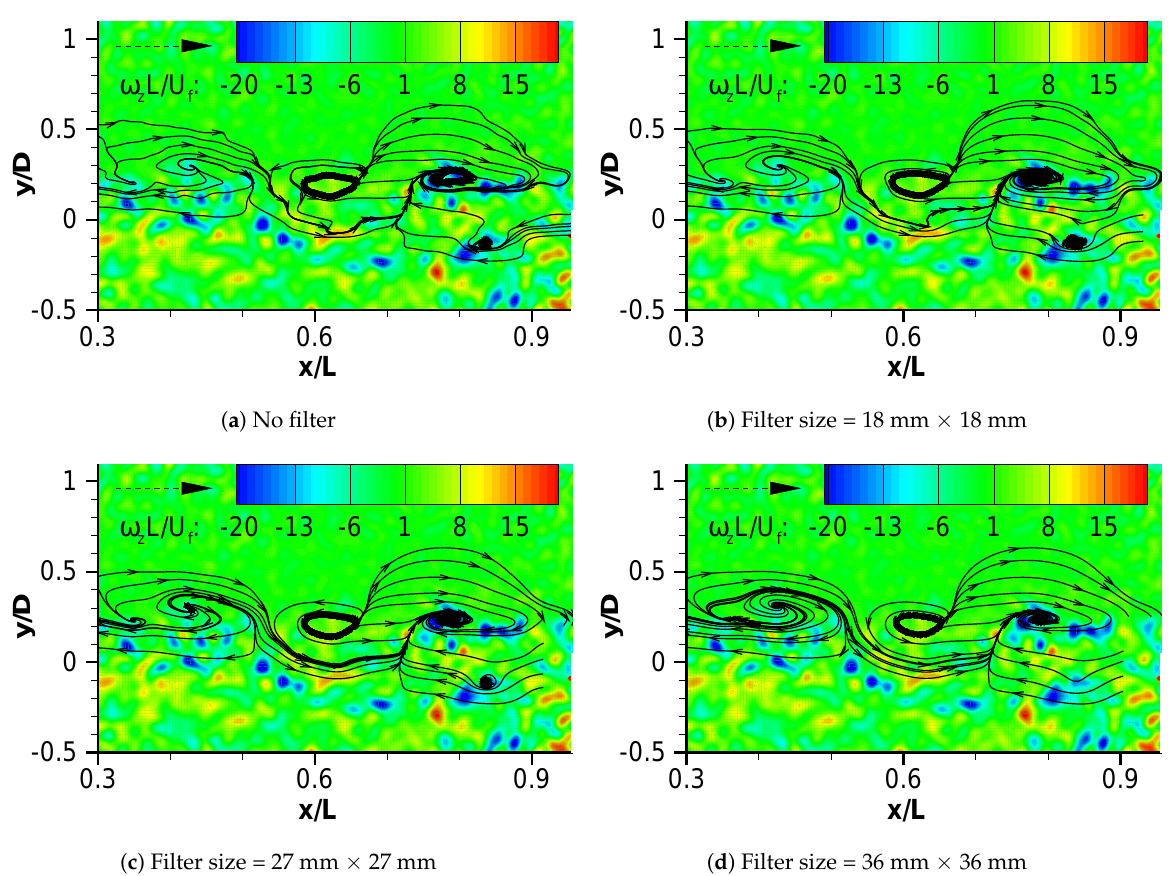
Figure 16. Snapshots of the instantiation vorticity and the fluctuating velocity streamlines with different filter sizes. The dashed arrow indicates the free stream direction. Re D ≈ 50,000; sharp edge at LE;